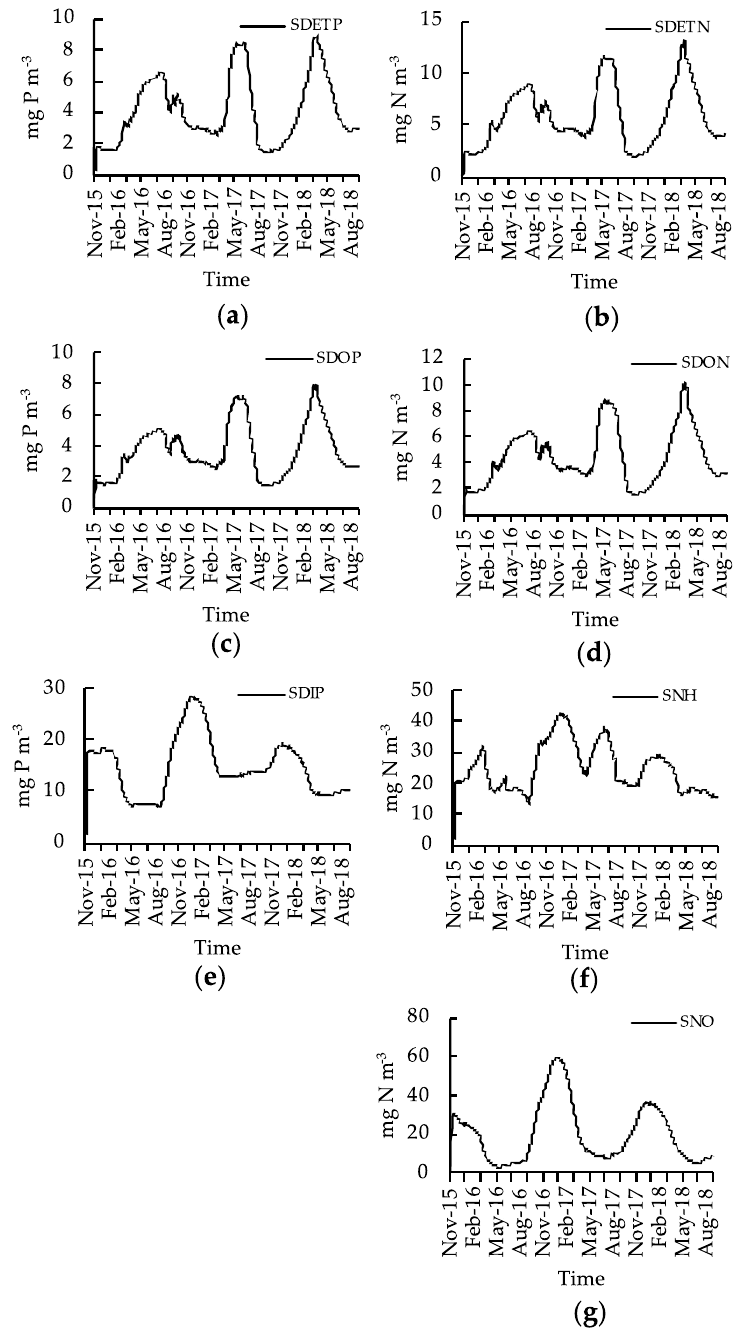
Figure 5. Seasonal changes in the estimated nutrients: ( a ) sediment detritus-P (sedimentDET-P); ( b ) sediment detritus-N (sedimentDET-N); ( c ) sediment dissolved organic P (SDOP); ( d ) sediment dissolved organic N (SDON); ( e ) sediment dissolved inorganic P (SDIP); ( f ) sediment ammonium (SNH); and ( g ) sediment nitrate (SNO) in the benthic system of the ATR-deployed area.